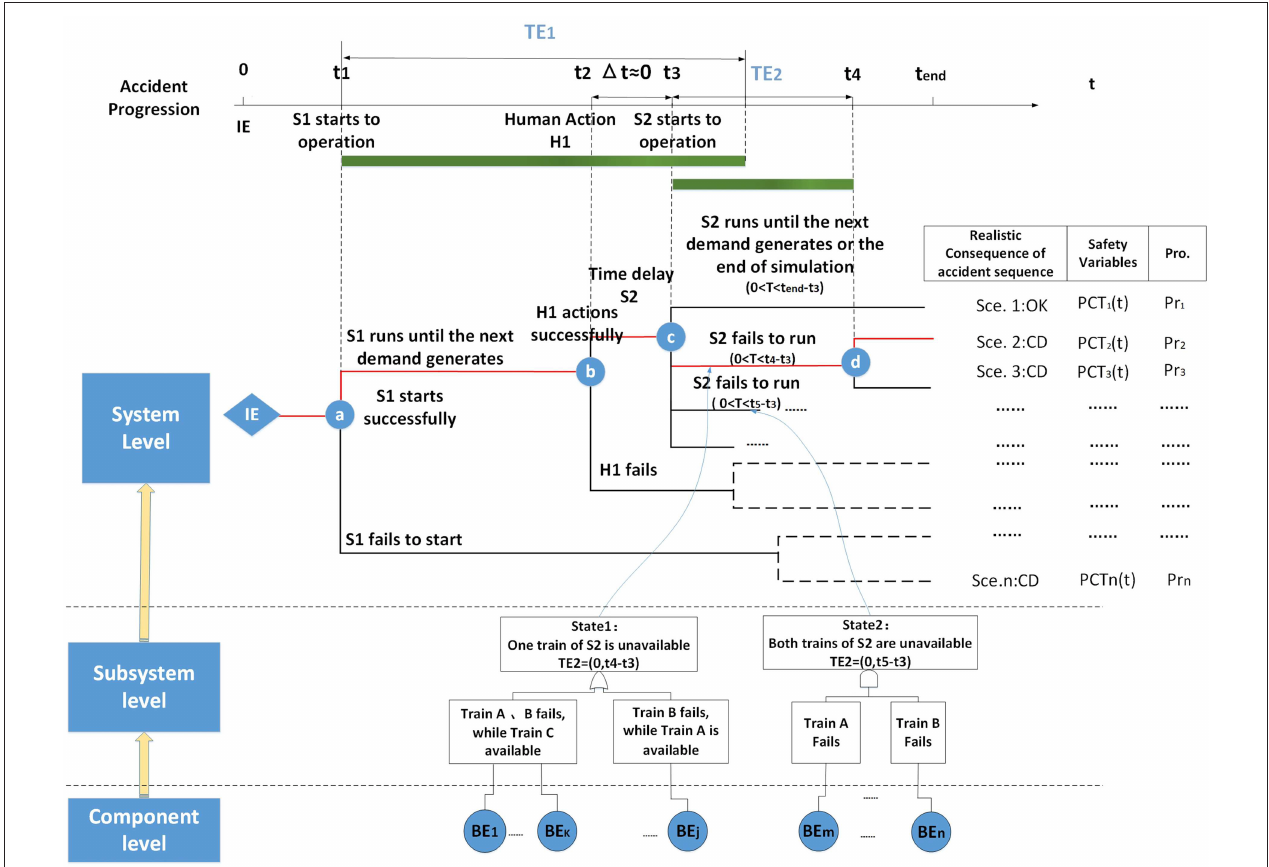
FIGURE 4 | Hierarchical structure of integration FT into